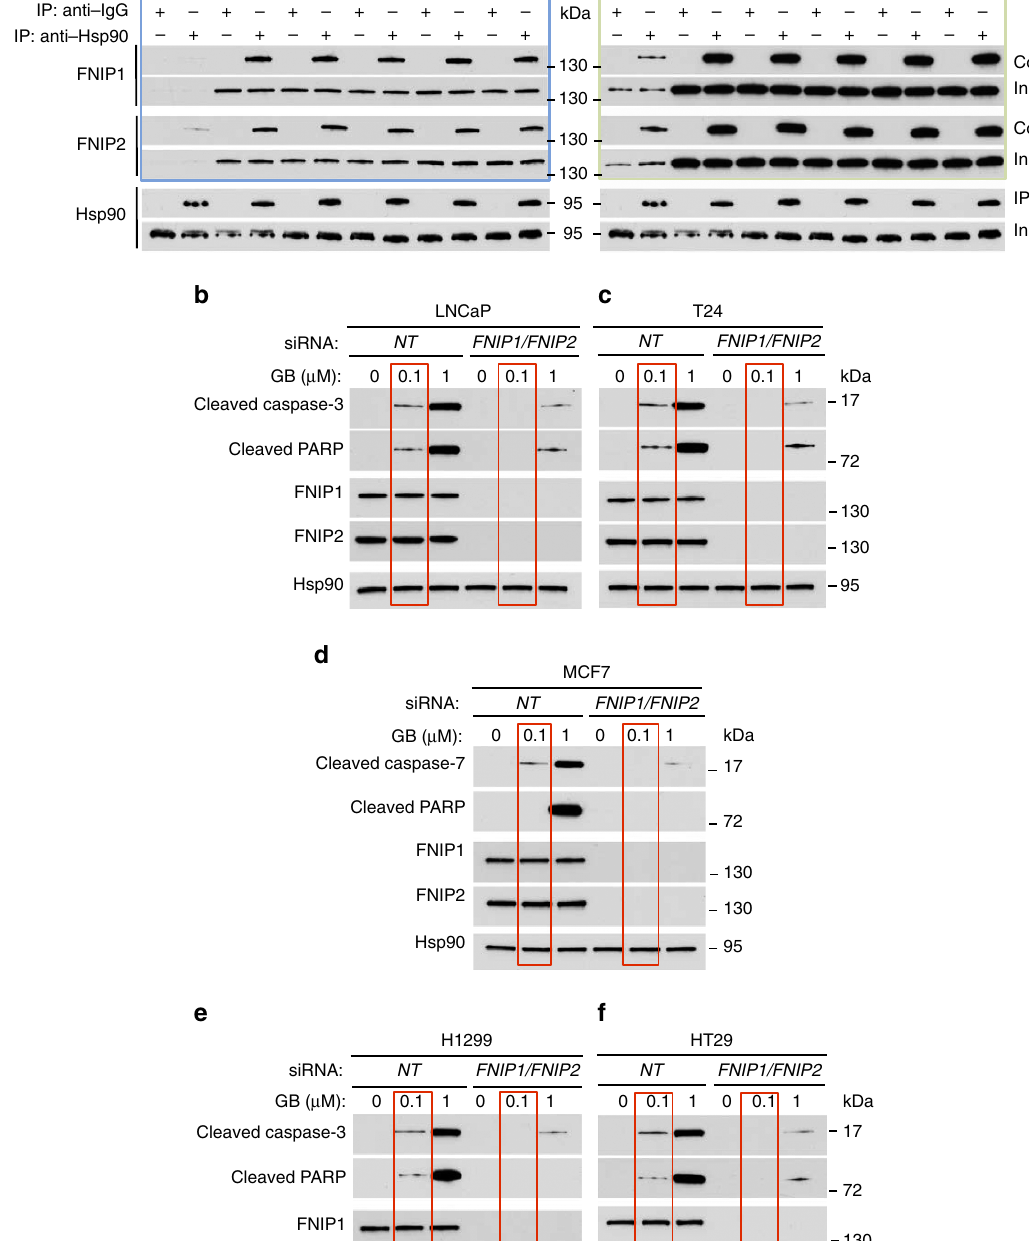
region of FLCN 8,26 . Truncating mutations result in loss of the C-terminus of FLCN, abolishing its interaction with FNIP1 and FNIP2, and consequently Hsp90. We speculate that loss of Hsp90 interaction with FLCN is the reason for the instability of the pathogenic FLCN mutants.